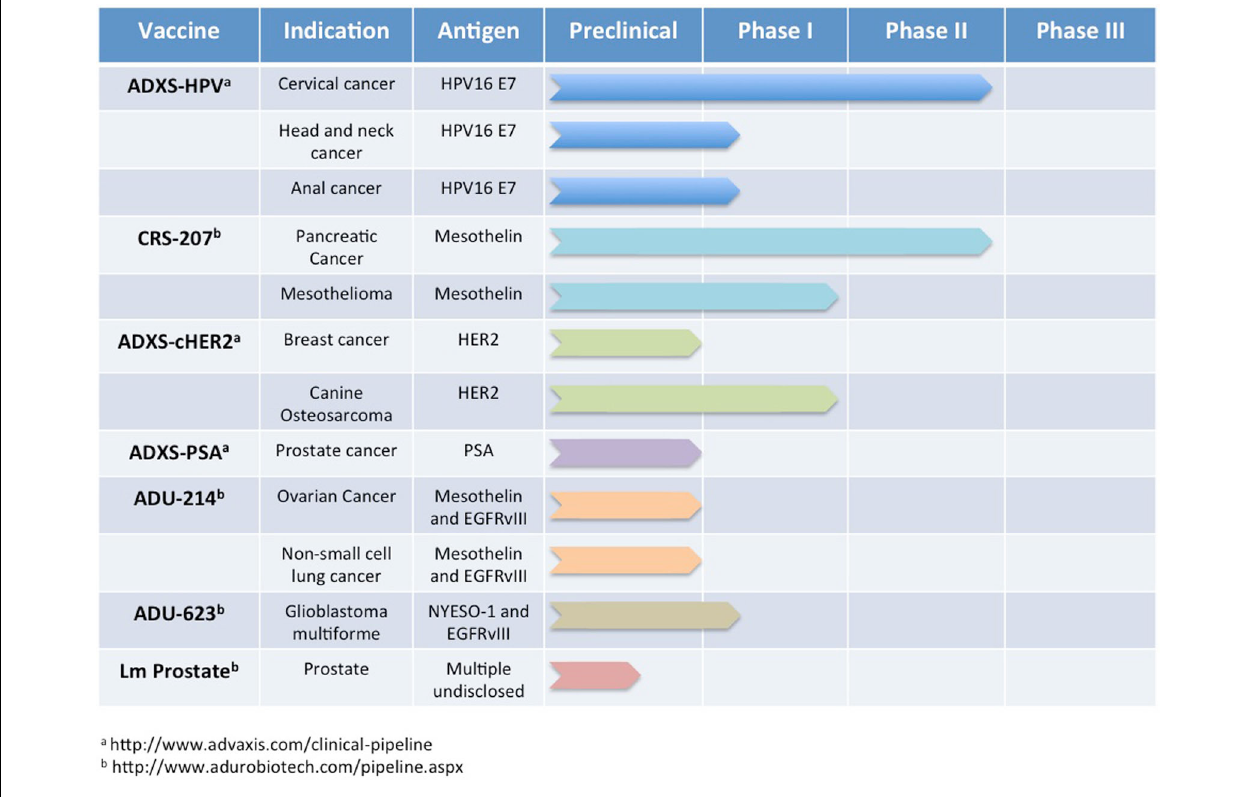
number of indications. In this figure, we summarize publicly available information for some of the Lm -based vaccines in clinical testing currently or planned for clinical testing in the near